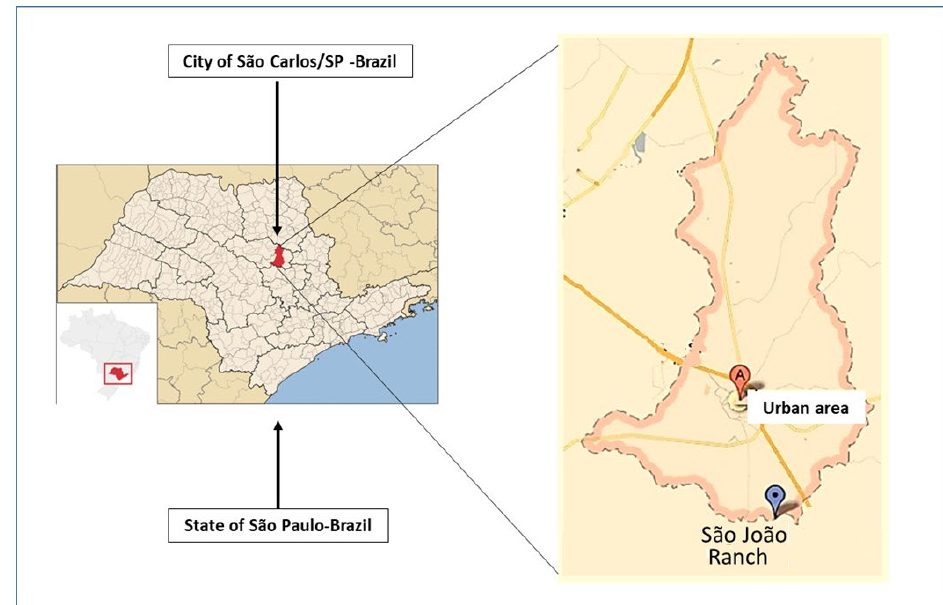
Fig. 3. Location of Ranch São João in the city of São Carlos-São Paulo, Brazil, adapted of Google Maps.